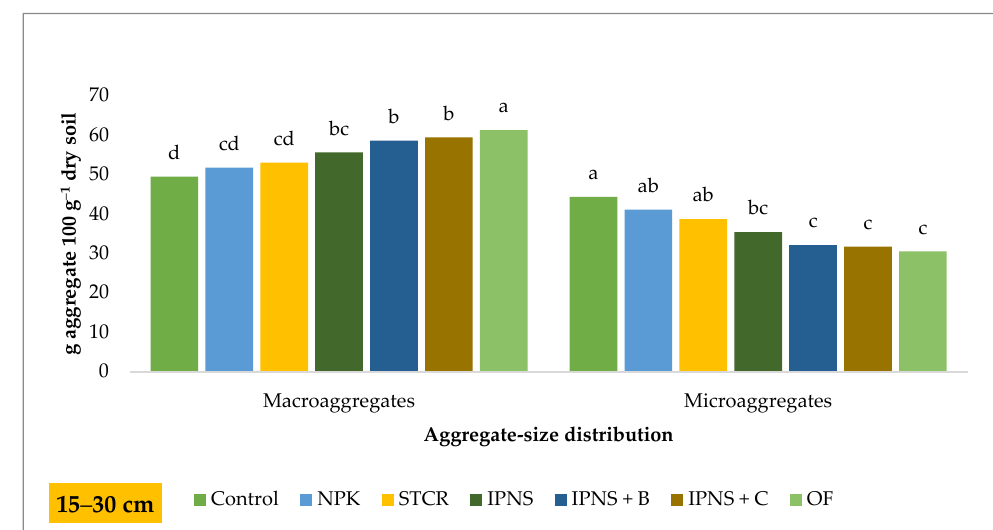
Figure 6. Effect of long-term nutrient supply options on macroaggregate and microaggregate frac- tions in the 15–30 cm soil layer of a rice–wheat cropping system. Means of different treatments followed by the different lower-case letters are significantly different at p < 0.05 level of significance according to DMRT.